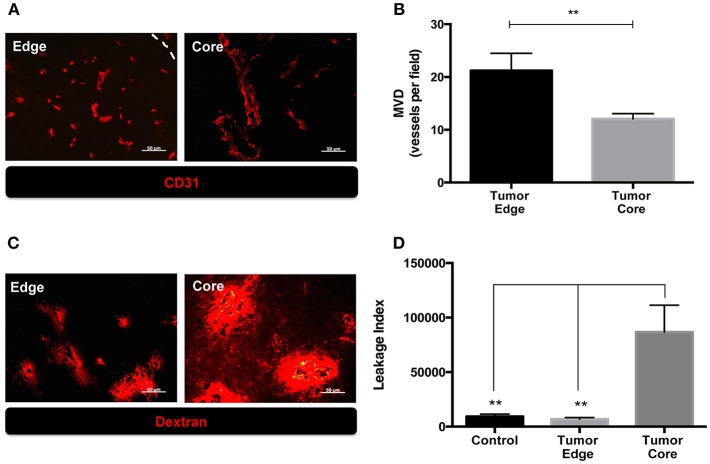
The microenvironment of tumor edge had higher microvascular density as well as better vascular function than those of tumor core in orthotopic ALTS1C1 tumors. Tumor sections at day 21 were stained with endothelial cell marker, CD31, and quantified. (A) Representative figures of CD31+ vessels in tumor core and edge. Tumor edge was defined as the distance of 200 μm inward from the tumor's boundary marked by white dotted line. (B) MVD was defined as the number of CD31+ vessels per field under 40X magnification. At least 10 fields per section were analyzed. Three sections of each tissue was calculated. Each group had at least three mice for data analysis. (C) The integrity of vasculatures in brain tissues injected with PBS (control) and ALTS1C1 tumor cells was examined by 70 kDa dextran distribution. (D) Leakage index was defined as the ratio of the signals (pixels) of dextran to the number of CD31+ vessels. All data points were analyzed in triplicate and values displayed are means ± SDs. The significant difference of treatment groups were compared with control group and analyzed by ANOVA. **P < 0.01. Scale bar = 50 μm.